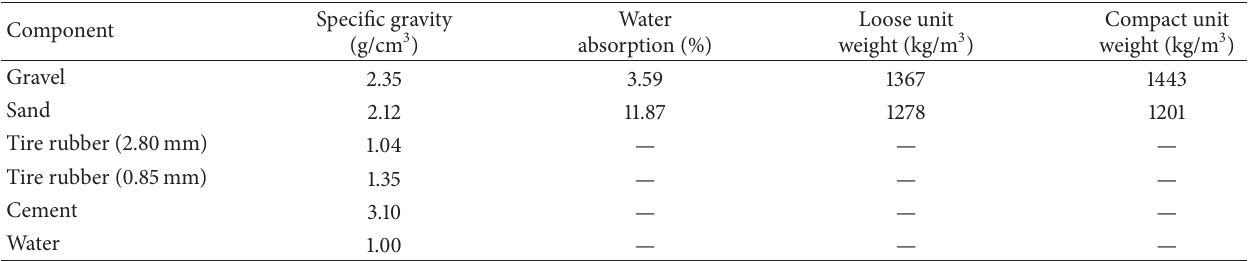
Table 1: Physical properties of components of concrete.